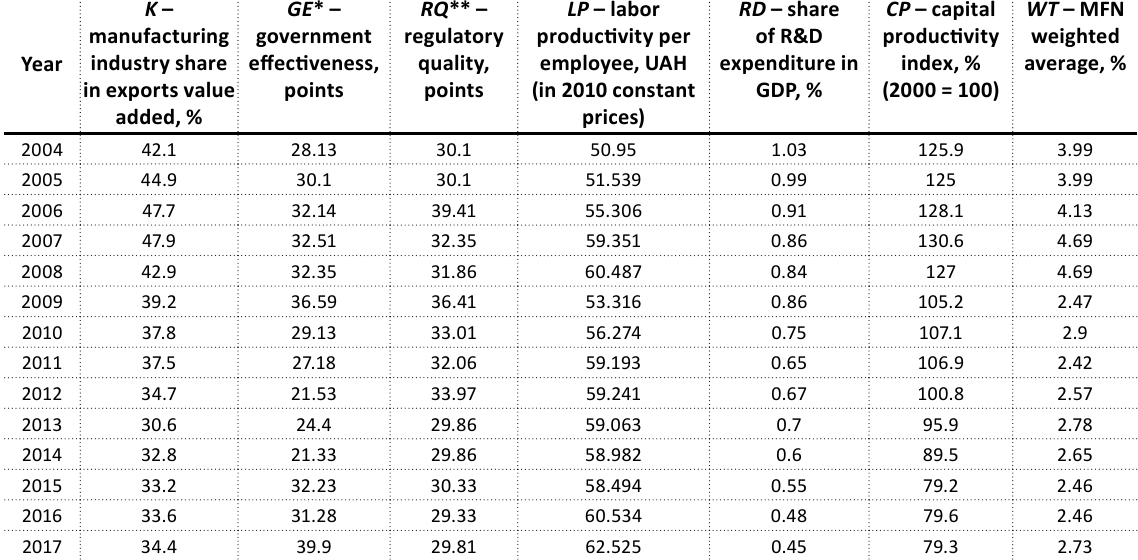
Table 1. Data for regression analysis